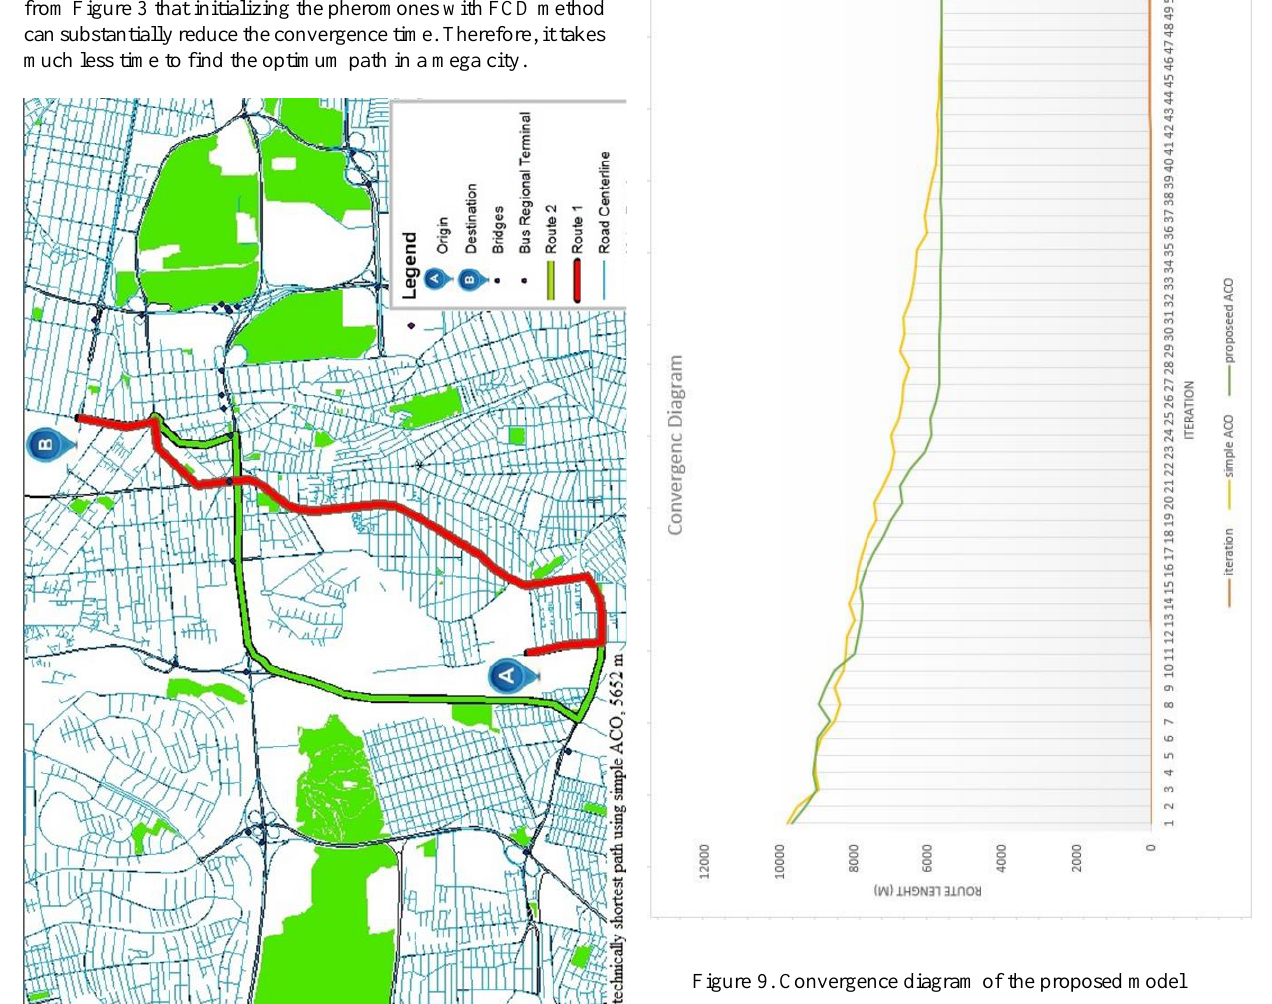
Figure 9. Convergence diagram of the proposed